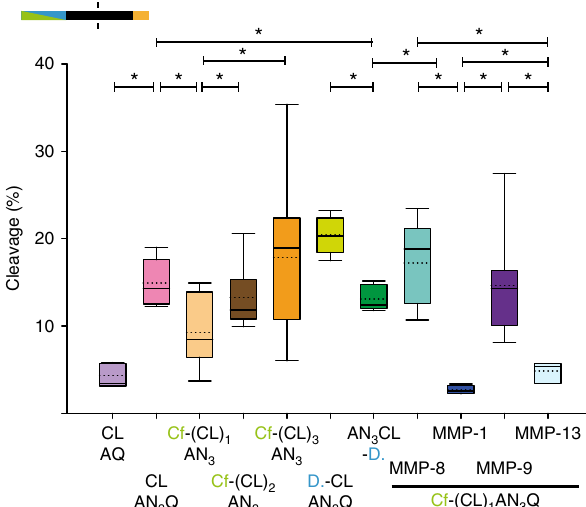
Fig. 3 Cleavage (%) of PCL conjugates (incubation for 60 min). Detailed information on the tested peptides is provided in Supplementary Table 1. CL protease cleavable linker with the sequence GPQG~IAGQ with ~ indicating the MMP cleavage site. Amino-acid variations at the fl anks of the PCL are given in one letter amino-acid code; AN 3 azido alanine, Cf carboxy fl uorescein, D denatonium carboxylate and (CL) 2 , and (CL) 3 are two and three consecutive repetitions of the PCL. MMP concentrations were 900 ng/mL and all experiments were performed with n ≥ 5.